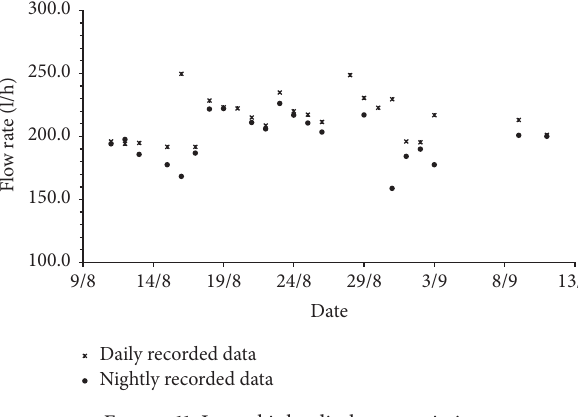
Figure 11: Lateral inlet discharge